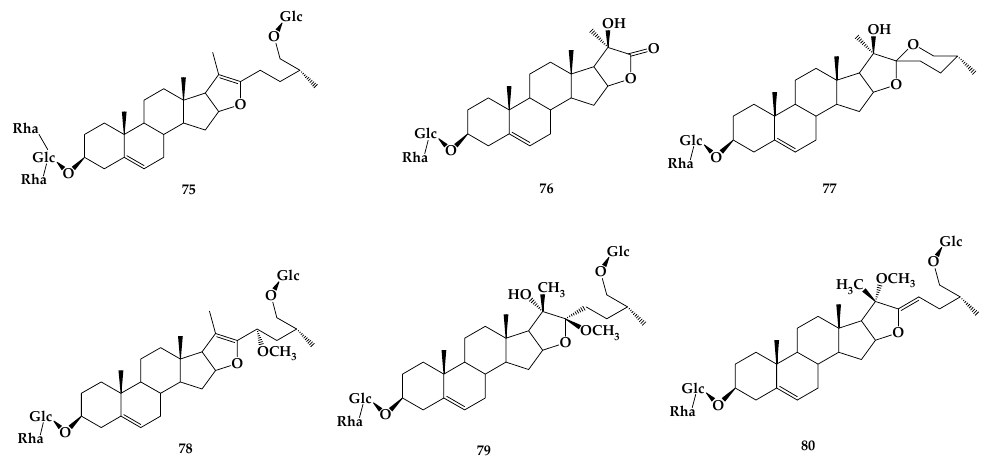
Figure 15. The chemical structures of compound 75–80